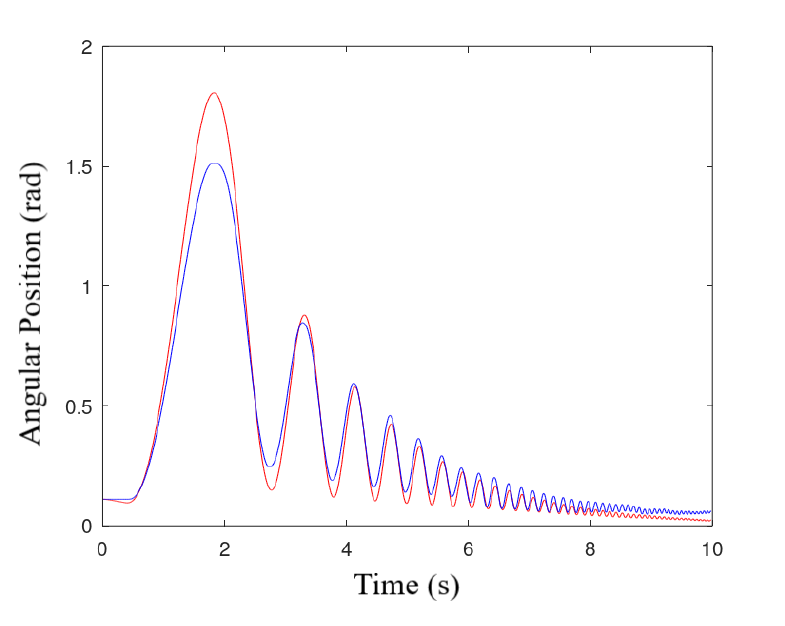
Figure 11. Rigid joint model vs. real angular positions.